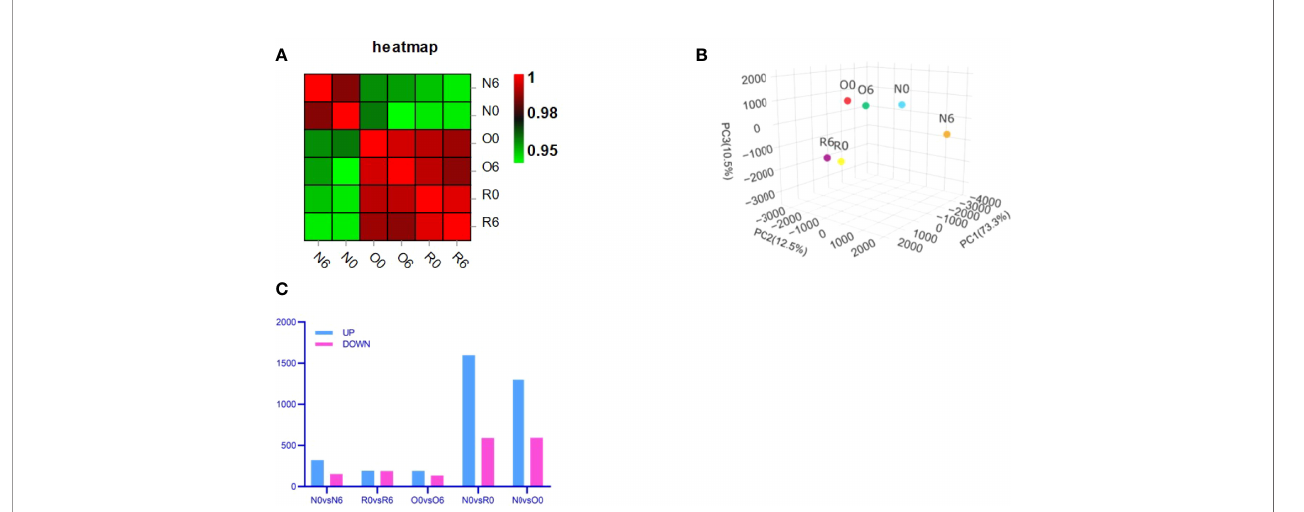
FIGURE 2 | Transcriptome analysis showed an ideal cell line modeling. Correlation heat map (A) and Principal Component Analysis (PCA) (B) were used to assess intra- and inter-group differences in the samples. Bar charts showed the number of signi fi cantly different genes between groups (FDR < 0.05, multiple of difference greater than or equal to 2) (C)